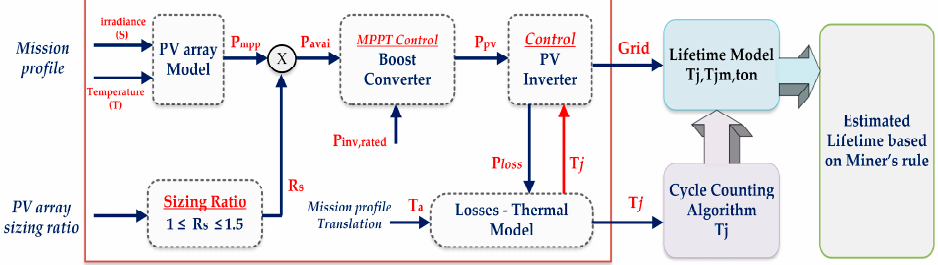
Figure 33. Mission pro fi le-translation diagram of a single-phase PV system, where the PV array sizing ratio Rs is taken into account.